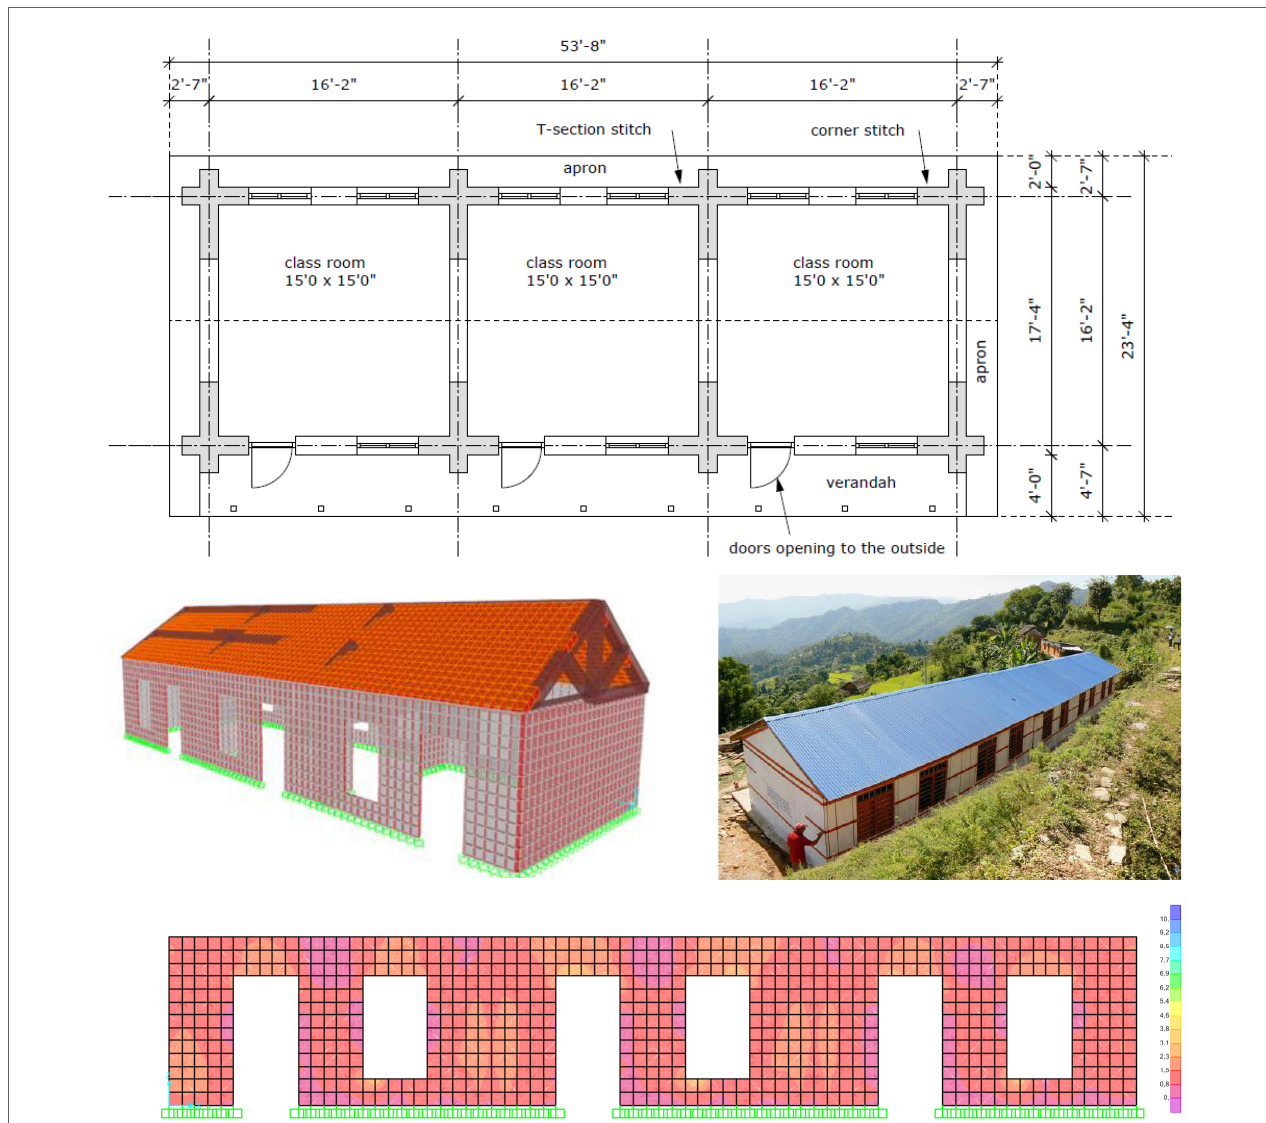
FigURe 14 | From top to bottom: plan of the three-classroom school building; FE model of the single block; photo of a two-block school (the blocks are separated by a 100 mm gap); envelope of the shear stress (kg/cm 2 ) from time-history